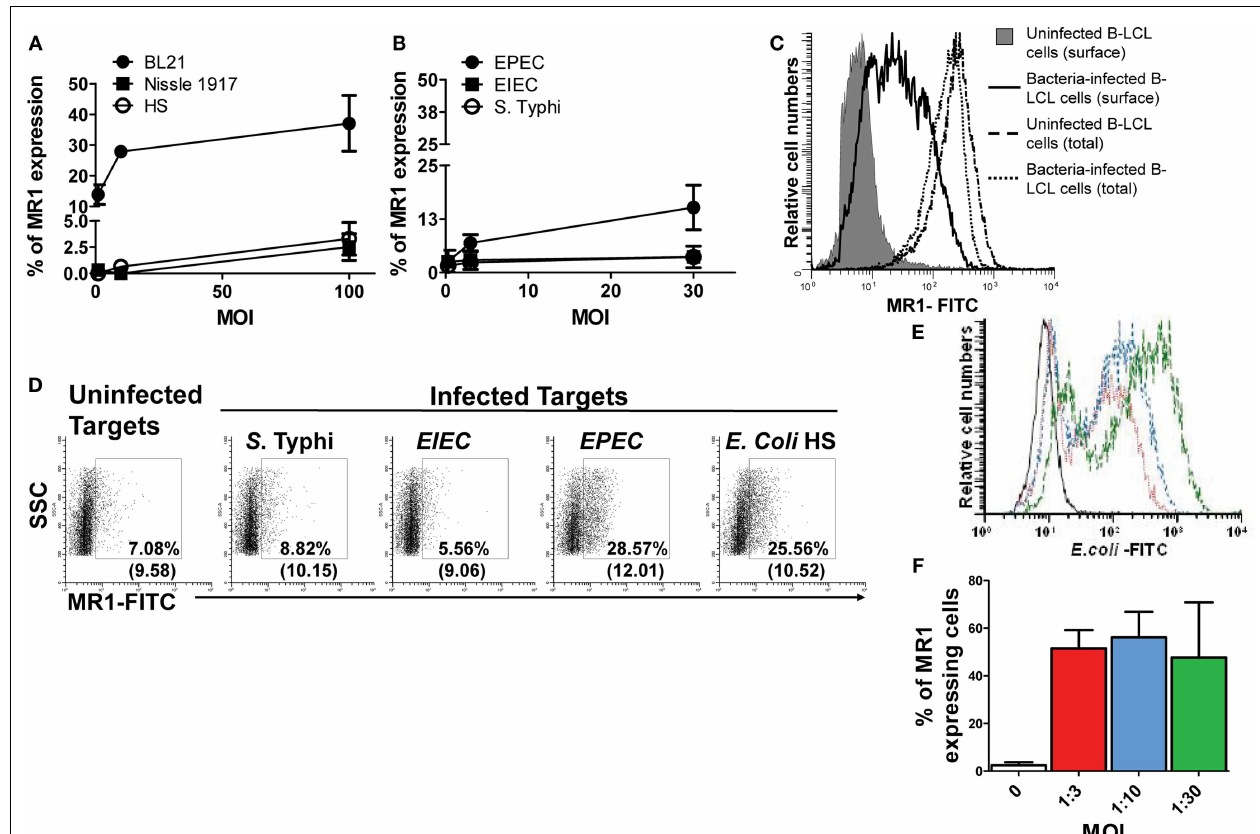
BL21-infected-cells (MOI 1:30) (full and dotted lines) were determined by flow cytometry. (D) HCT-8 epithelial cells were left uninfected or infected with either S. typhi , EIEC , EPEC , or E. coli HS at an MOI of 1:100 for 2h. After 16–18h of gentamicin treatment cells were stained with MR1 antibodies and analyzed by flow cytometry. Numbers correspond to the % of MR1 positive cells followed by mean fluorescence intensity (MFI) of positive cells (in parenthesis). Primary B cells were also infected with E. coli strain BL21 at different MOI ( ··· , 1:3; ··· ,1:10; and ··· , 1:30) and surface expression of E. coli antigens (E) and MR1 expression (F) measured by flow cytometry. Data are representative of five (A,B) and two (B–F)